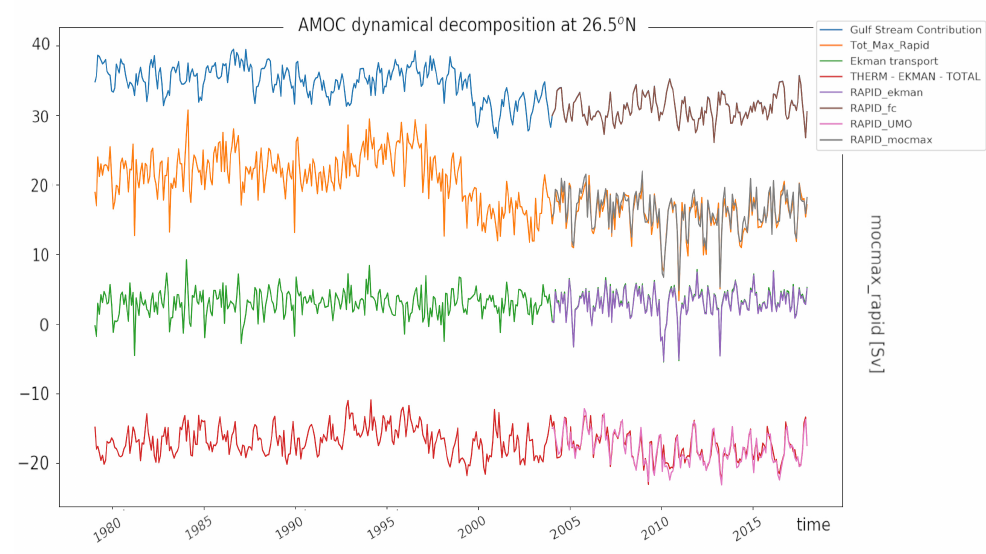
Figure A2. Dynamical decomposition as in the rapid